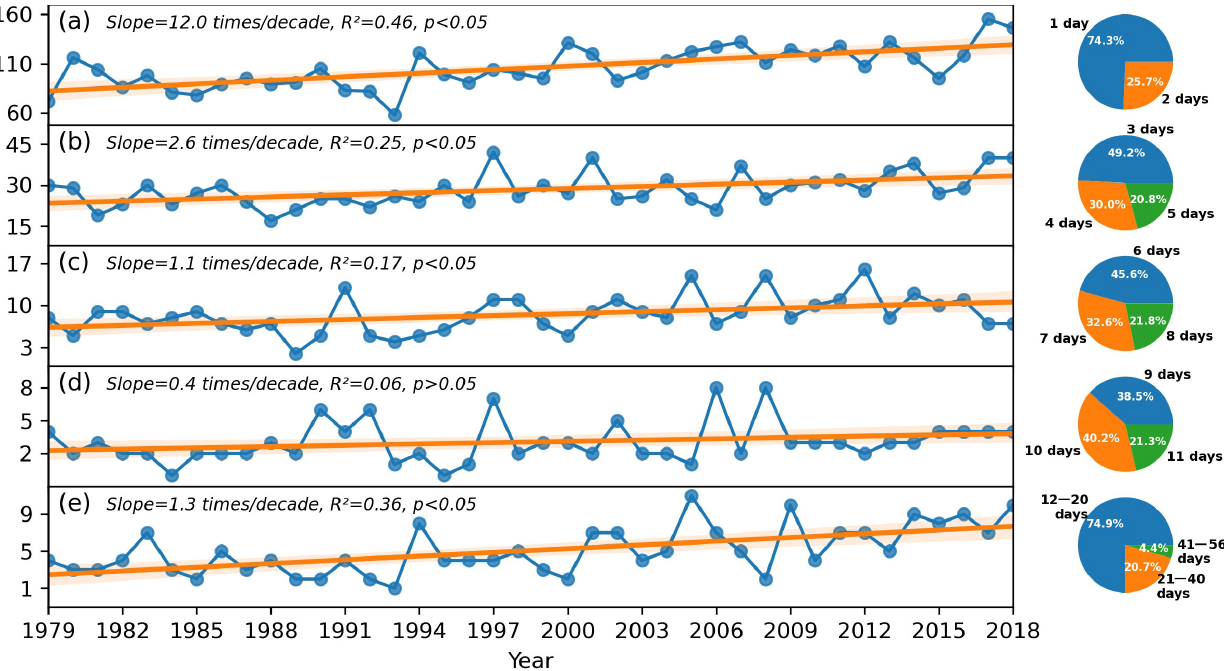
Figure 4. Variations of heatwave event frequency of different durations between 1979 and 2018 across China. ( a ) 1 – 2 days, ( b ) 3 – 5 days, ( c ) 6 – 8 days, ( d ) 9 – 11 days, and ( e ) more than 12 days. Pies on the right side represent the percentage of individual-duration frequency to total frequency for the durations over 1979–2018, e.g., the percentage of 1-day event frequency to 1– and 2–day frequency in the 1979–2018 period is 74.3%. Table 2. The heatwave event frequency in seven regions of China in the 1979–2018 period. For the last two columns, the maximum duration and maximum influence area of the heatwave event in the region are given, and the associated onset dates of the heatwave events are listed in brackets. D and IA are the abbreviations for duration and influence area,